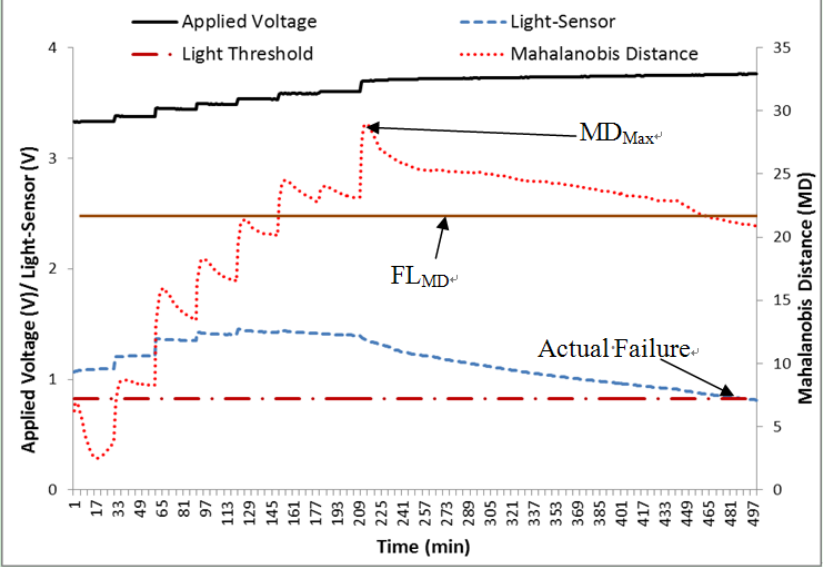
Figure 17. MD history and the MD failure limit for LED test data in the Figure 13.